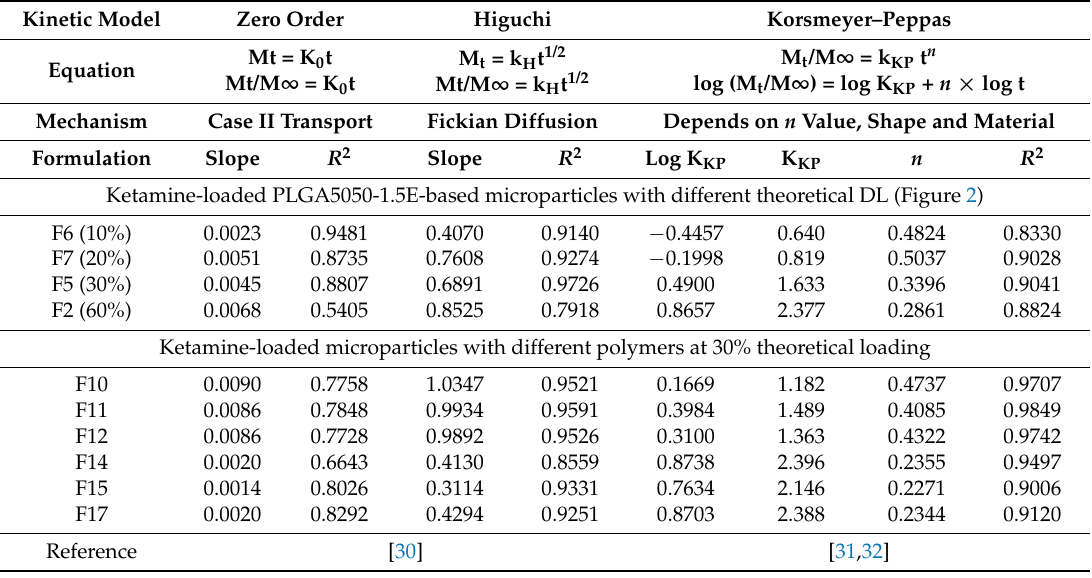
Fit parameters of the kinetic model for the release of ketamine-loaded PLGA5050-1.5E-based